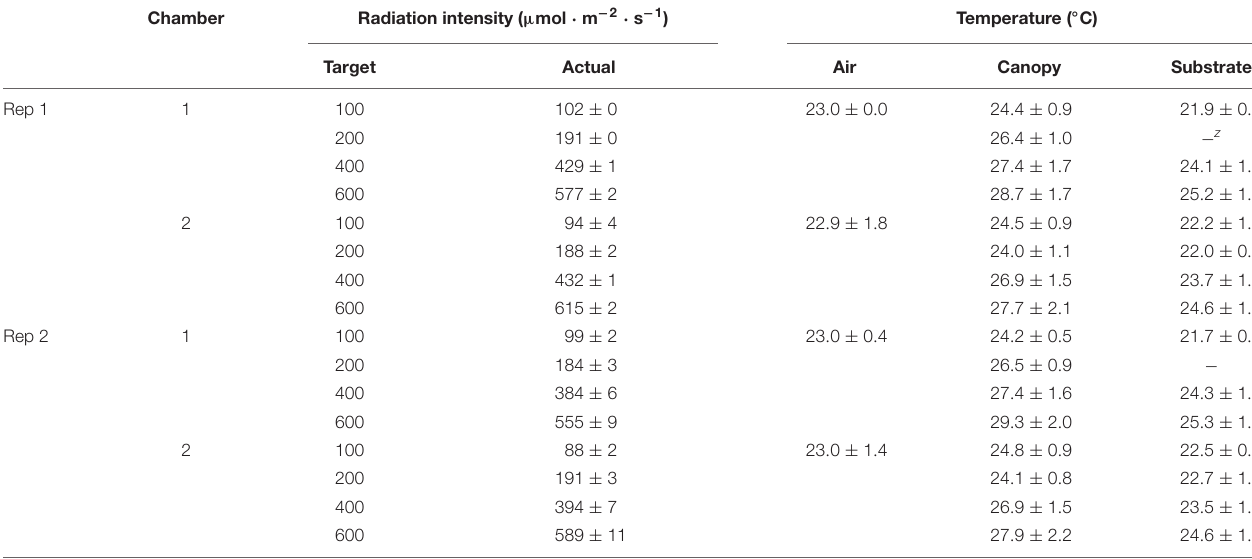
TABLE 1 | Target radiation intensity, actual radiation intensity, and average daily air, canopy, and substrate temperatures (mean ± SD) during the seedling growth stage (2 weeks).